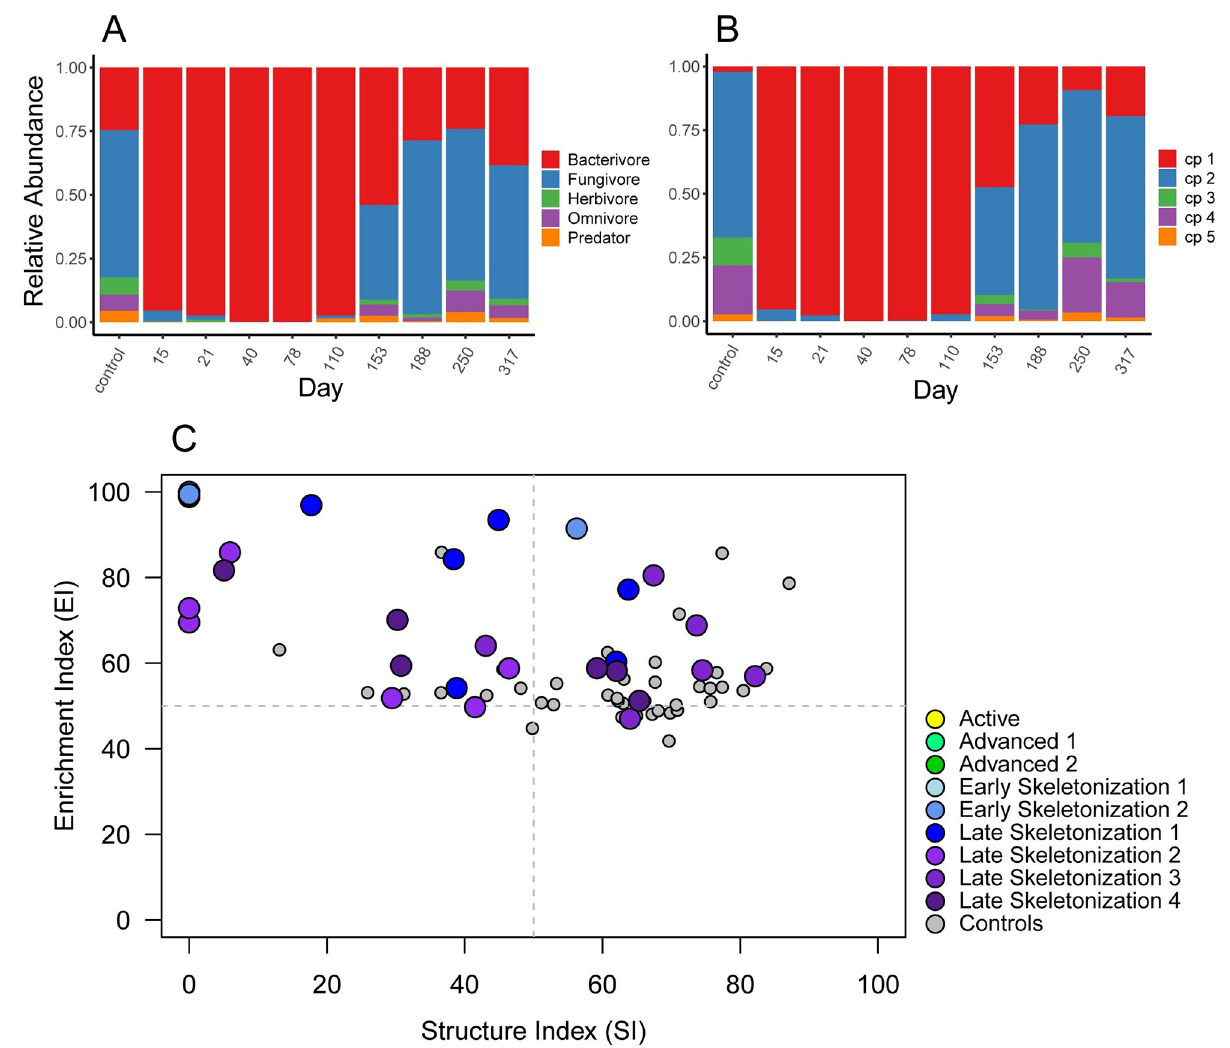
Fig 5. Temporal changes in nematode community composition and functional diversity in interface (0–1 cm) soils. Relative abundances of (A) trophic groups, (B) cp-classes, and (C) functional diversity analysis for interface (0–1 cm) soils.